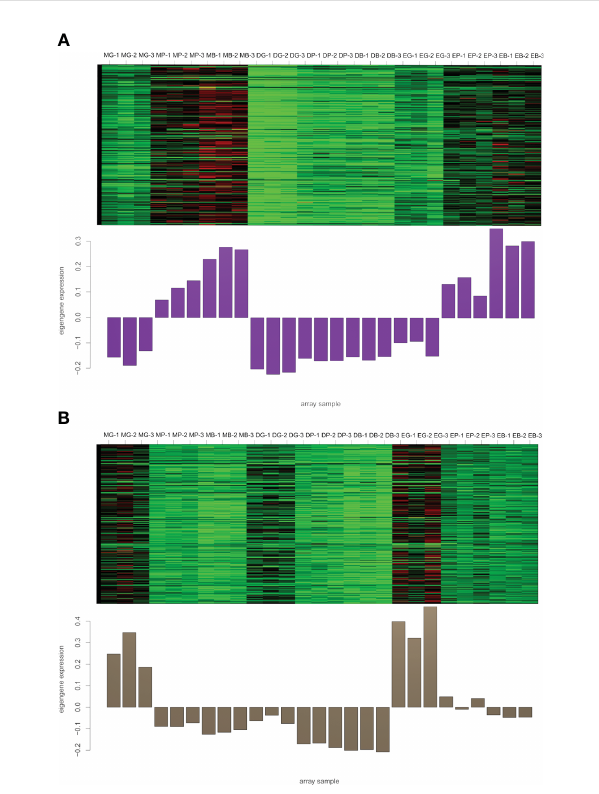
FIGURE 4 Heatmap of genes and eigengene expression in the darkviolet and bisque4 modules. (A) Heatmap of genes and eigengene expression in the darkviolet module. (B) Heatmap of genes and eigengene expression in the bisque4 module. DG, Duke green stage; DP, Duke pink stage; DB, Duke blue stage; EG, Emerald green stage; EP, Emerald pink stage; EB, Emerald blue stage; MB, Misty green stage; MP, Misty pink stage; MB, Misty blue